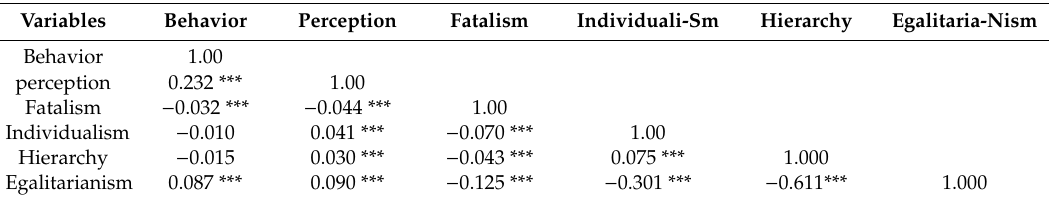
Table 5. Correlation matrix of main variables.